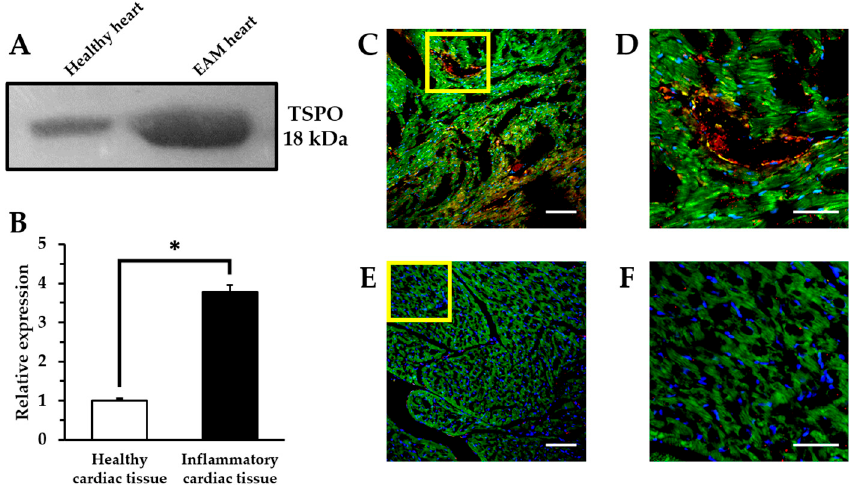
Figure 4. Ex vivo analysis of TSPO expression. Western blotting analysis of heart samples ( A , B ). (* p < 0.01). Representative immunohistochemical images indicating the expression level of CD68+ macrophages and TSPO in inflammatory myocardial tissue ( C , D ) and healthy myocardial tissue ( E , F ) by confocal laser scanning microscopy. Highly magnified images of the yellow box in ( C , E ), respectively ( D , F ). Blue: nucleus; green: mitochondria; red: TSPO; yellow: macrophages. Scale bars: 100 µm (×20) and 50 µm (×60).